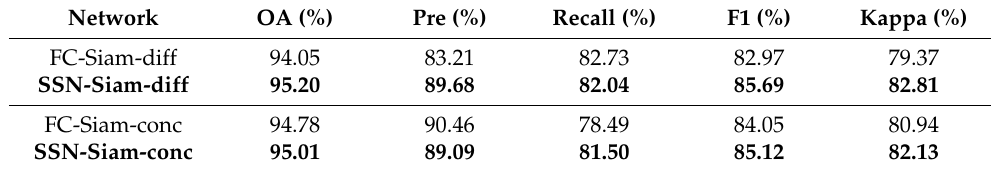
Table 6. Quantitative results of transfer learning experiment for Yellow River–Farmland-A dataset.